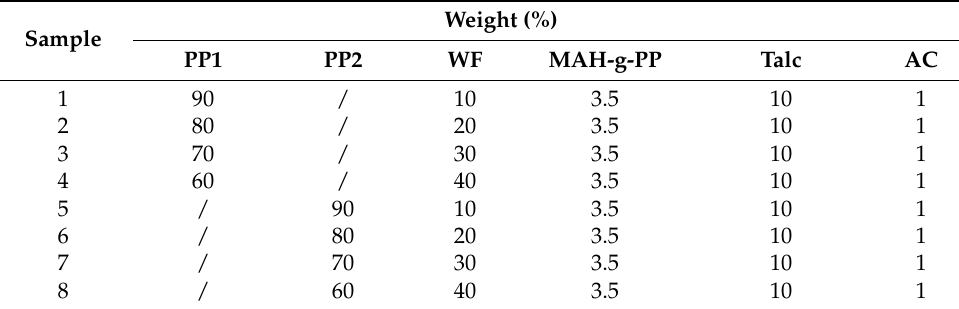
Table 1. The formulation of PP/POE/wood–flour composites.